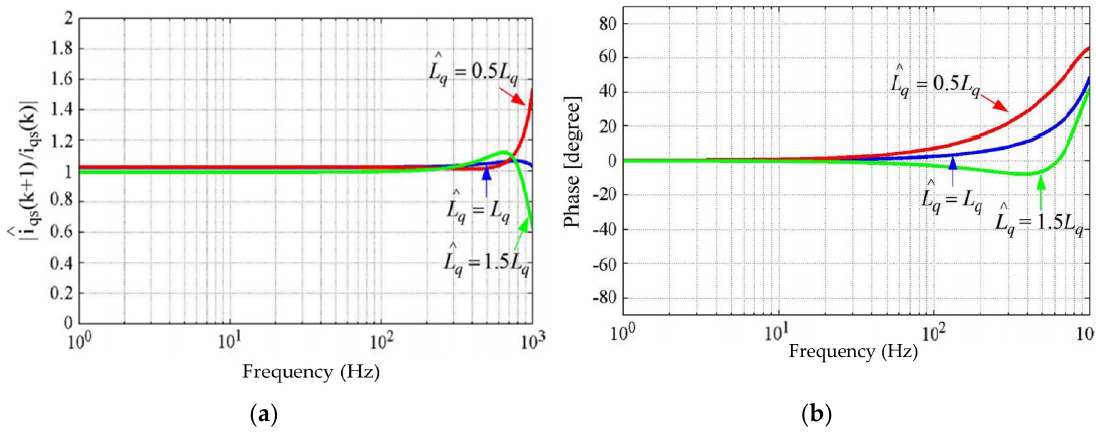
Figure 3. Estimation accuracy characteristic of a stator current observer with respect to q-axis inductance variation at a frequency domain [3]. ( a ) Magnitude of estimation accuracy; ( b ) Phase of estimation accuracy.